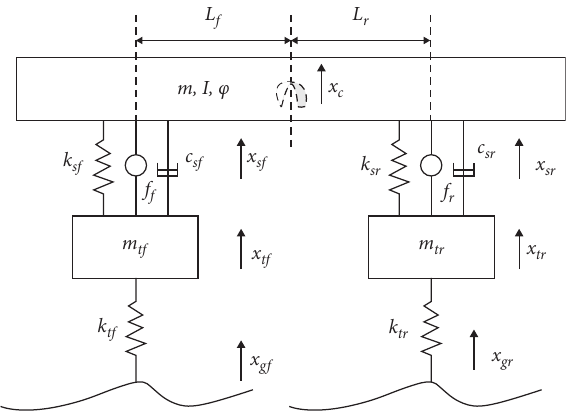
Figure 1: Four-degree-of-freedom suspension model with active control with double time-